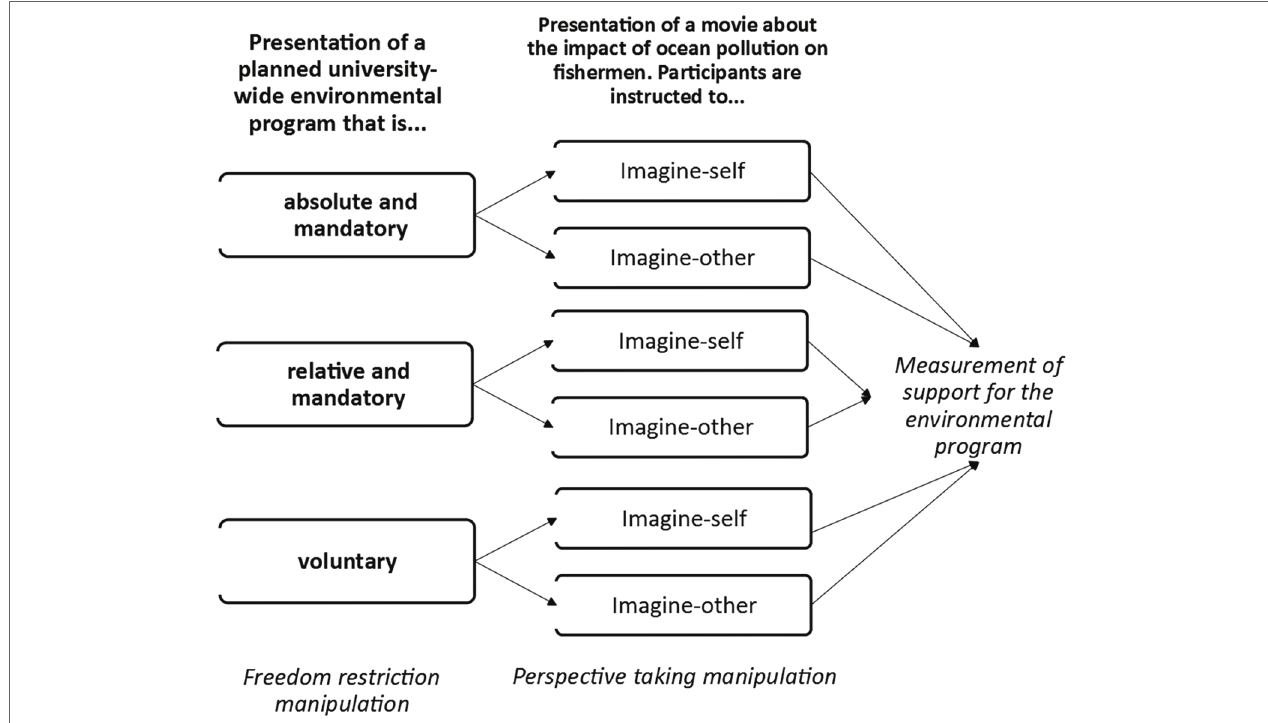
FIGURE 1 | Design of study 1.